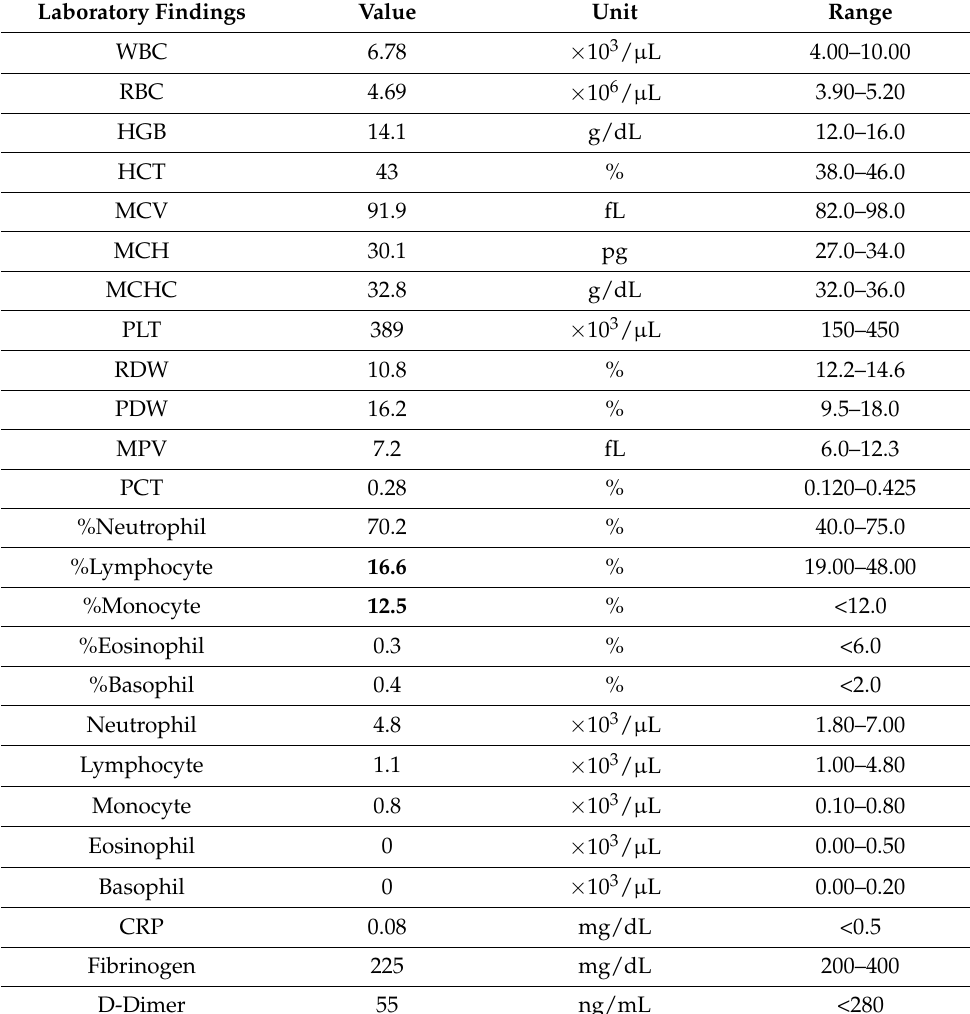
Table 1. Laboratory findings of mother during SARS-CoV-2